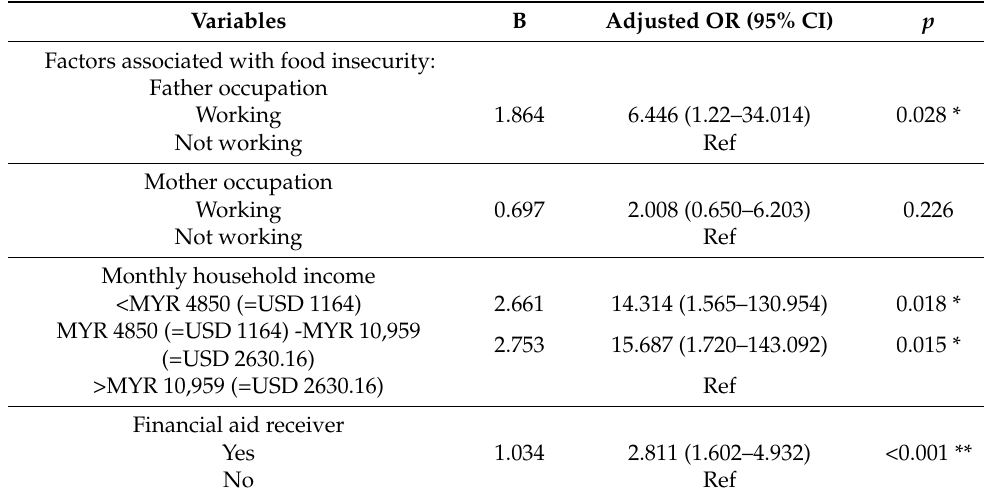
Table 3. Factors associated with food security status and its consequences towards psychosocial factors and academic